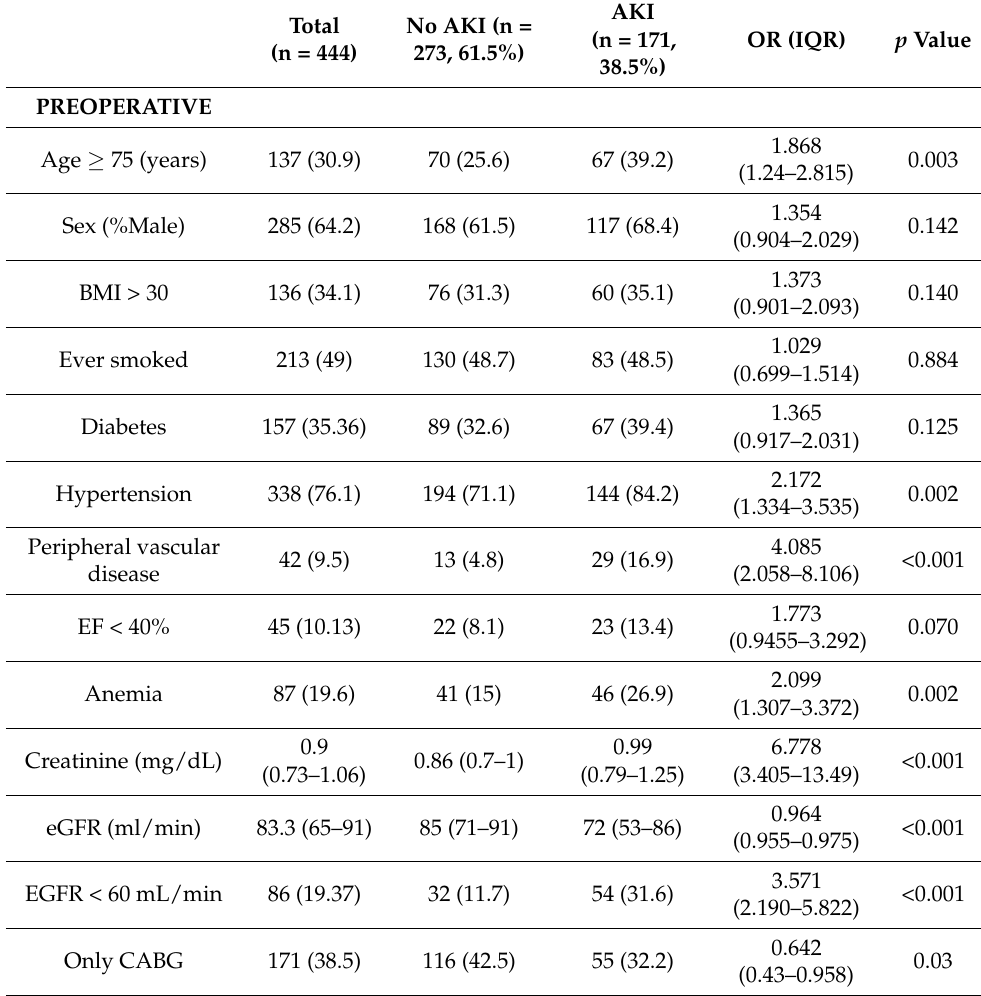
Table 4. Risk factors for cardiac surgery-associated acute kidney injury: univariate